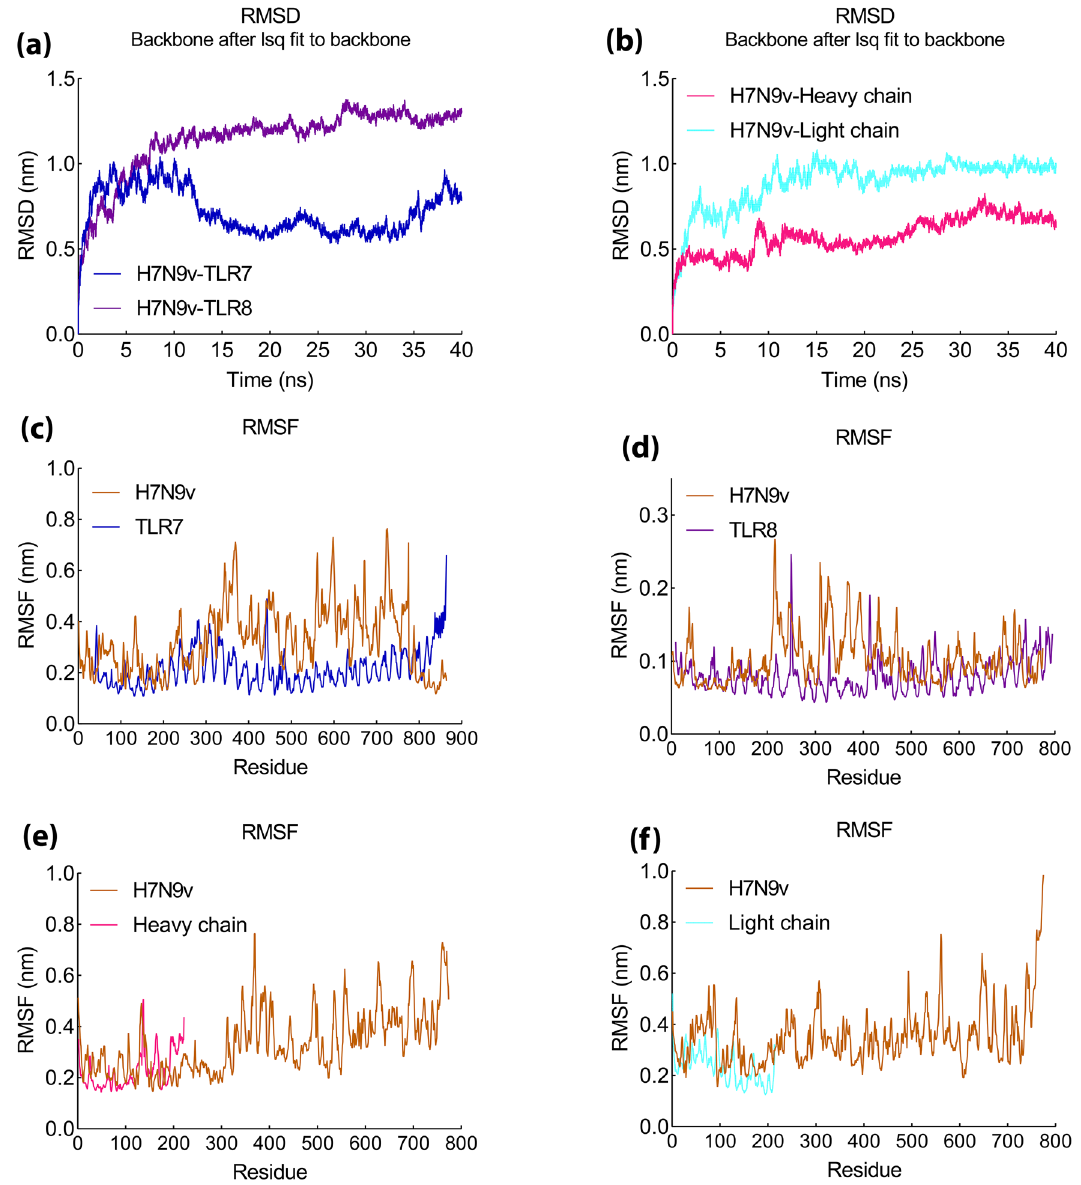
Figure 11. MD simulation results of H7N9v with proteins complex. ( a ) RMSD graph of H7N9vac-TLR7and H7N9vac-TLR8 complexes. ( b ) RMSD graph of H7N9vac-m826 Heavy chain H7N9vac-m826 Light chain complexes. ( c ), ( d ), ( e ) and ( f ) RMSF graph of H7N9vac-TLR7, H7N9vac-TLR8, H7N9vac-m826 Heavy chain and H7N9vac-m826 Light chain complexes.